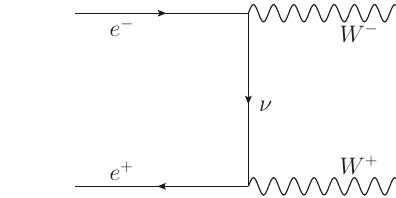
. The s -channel diagram on the (cid:0) ! WW